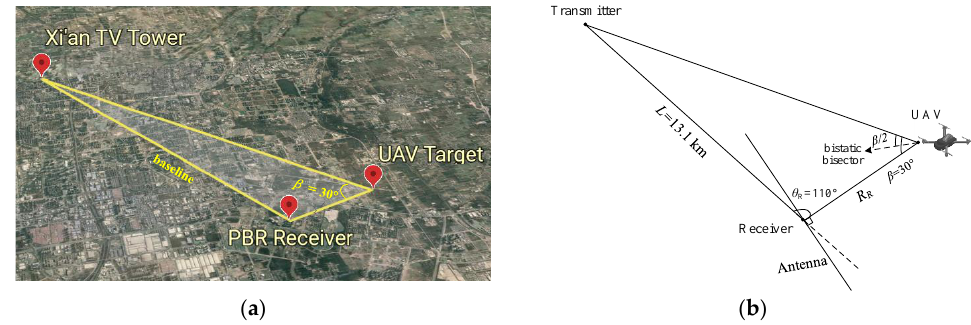
Figure 12. Geometry of the experiment: ( a ) the real geometric model; ( b ) the analytical model. Table 3. Clutter suppression ratio of different purification method.